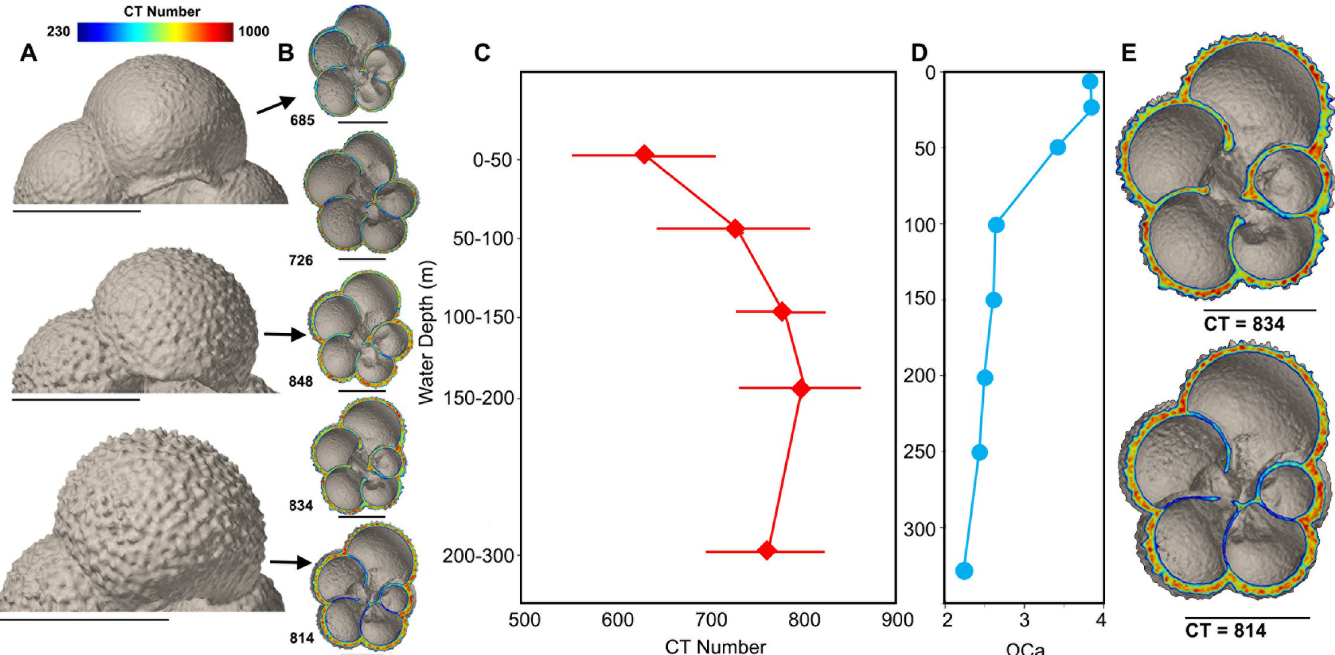
Fig 3. Turborotalita quinqueloba from water column. A) Texture of test surface of Turborotalita quinqueloba at three different depth intervals; 0–50 m, 100–150 m and 200–300 m. B) Variation in inner and outer shell density of T . quinqueloba as mean CT number of entire shell measured by XMCT increases. C) Mean CT number of T . quinqueloba (n = 115), with error bars, plotted against water depth. D) Calcite saturation at sampling site plotted against water depth. E) T . quinqueloba cross-section before and after assumed gametogenesis. Scale bars measure 100 μ